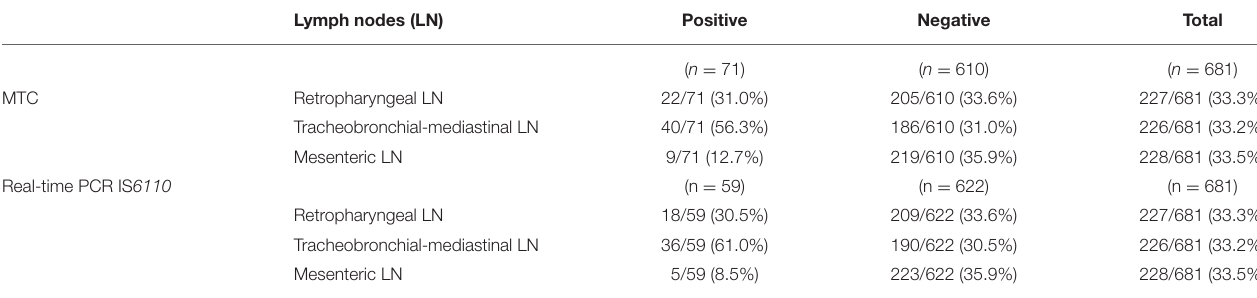
TABLE 1 | Results of Mycobacterium tuberculosis complex (MTC) culture and real-time PCR IS 6110 considering the examined lymph